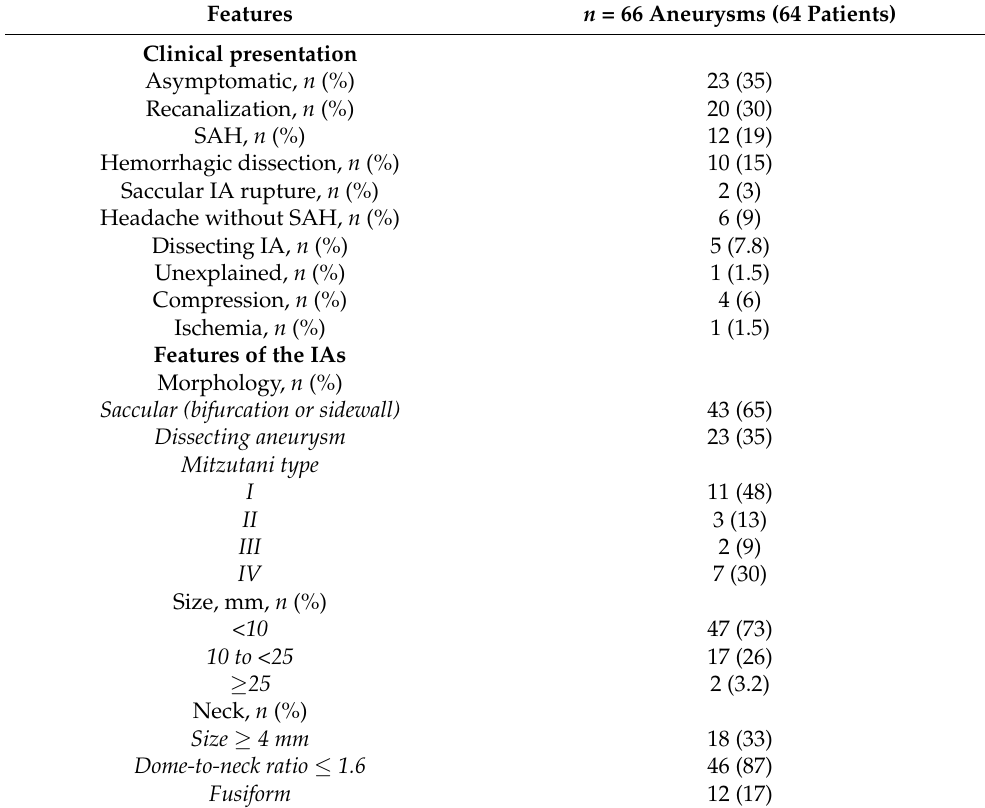
Table 2. Clinical presentation and main features of the 66 intracranial aneurysms in 64 patients managed with one or more Leo